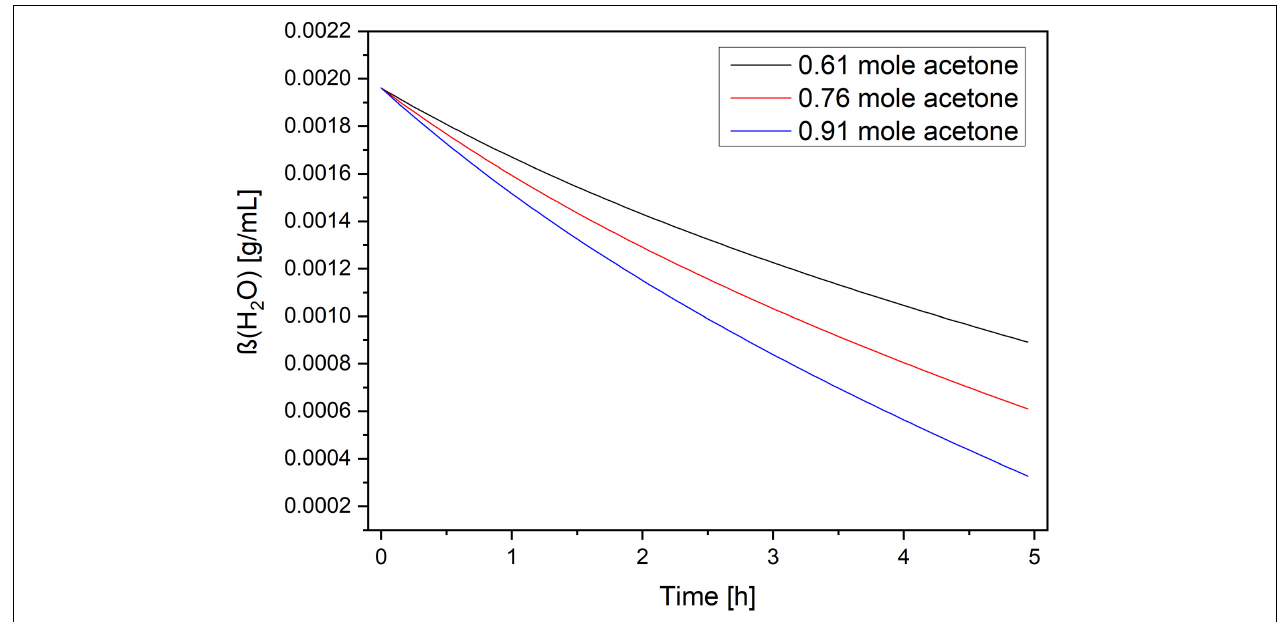
FIGURE 12 | Concentration of water plotted vs. time in